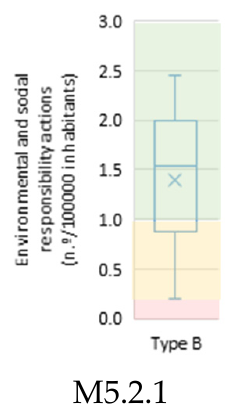
M6.4.1 Figure 10. Results of the validation applied to the wastewater utilities: objective 6. The management of occupational safety and health requirements at work (objective 7) has significant potential for improvement, especially for absenteeism (Figure 11, M7.2.1 and M7.2.2). M7.2.1 M7.2.2 Figure 11. Results of the validation applied to the wastewater utilities: objective 7.